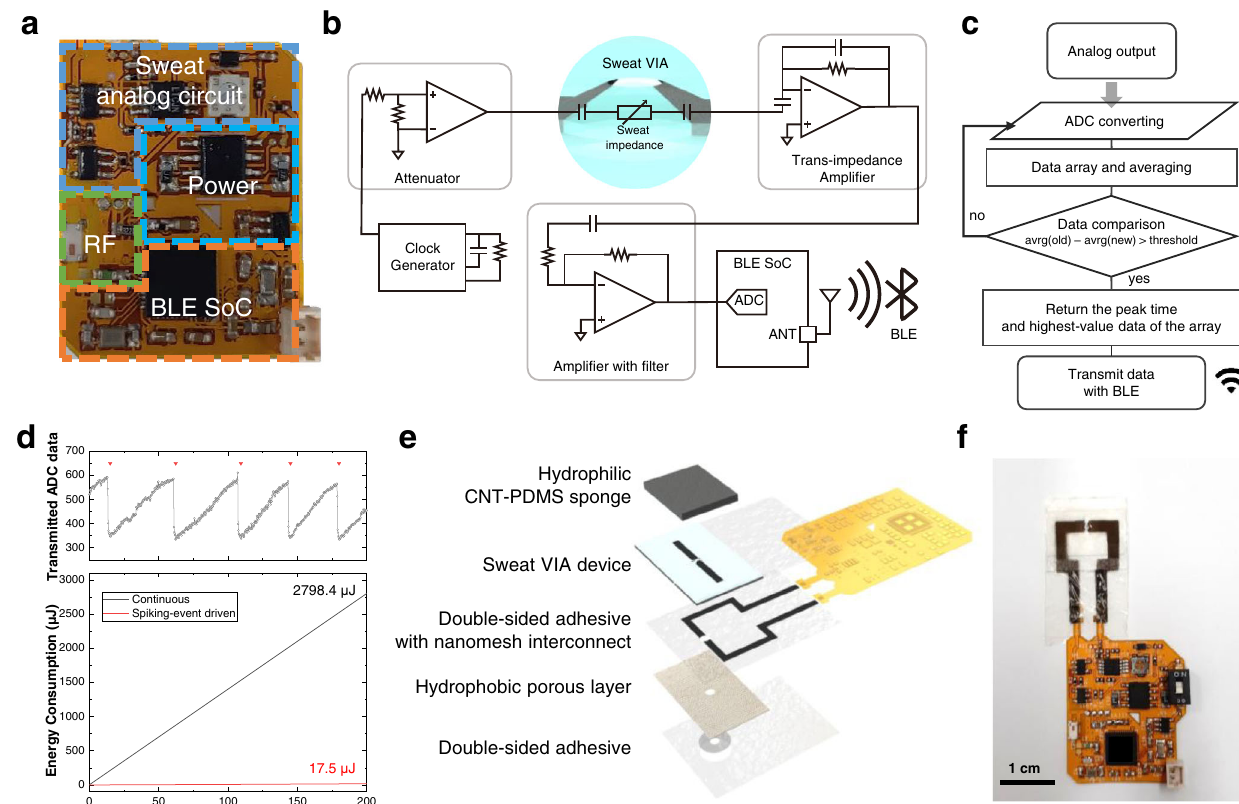
Fig. 5 | A sweat VIA-based epi fl uidic wireless patch. a Photograph of the fl exible printed circuit board – based wireless sensor platform for monitoring epidermal perspiration dynamics using the sweat VIA sensor. b Schematic diagram of the sweat VIA-based wireless sensor platform. c System-level block algorithm for the sweat VIA sensor enabling spiking-event-driven wireless data transmission.